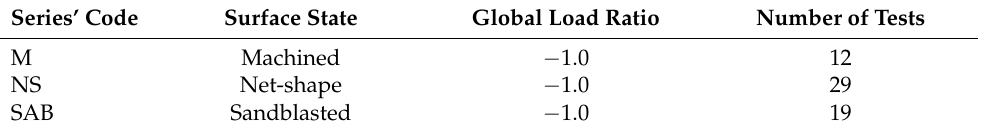
Table 1. Overview of fatigue tests performed on machined, net-shape and sandblasted samples. Series’